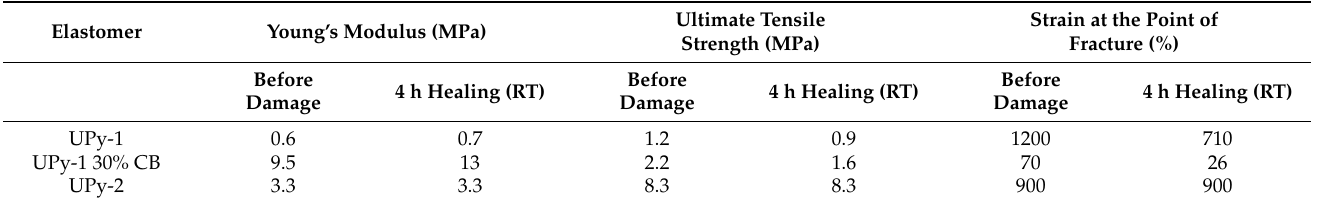
Table 1. The mechanical properties of the self-healing supramolecular elastomers UPy-1, UPy-2 and UPy-1 with carbon black filler, before damage and after 4 h of healing at room temperature (RT). The data are derived from Supplementary Figures S1 and